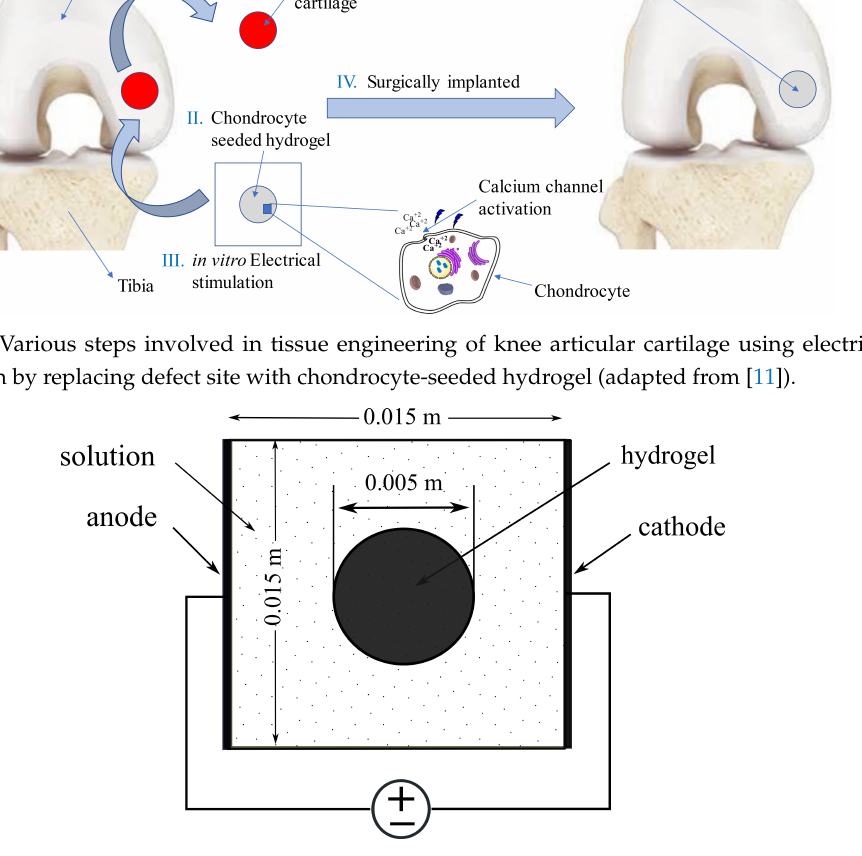
Figure 2. Hydrogel sample immersed in NaCl bath solution under externally applied electric